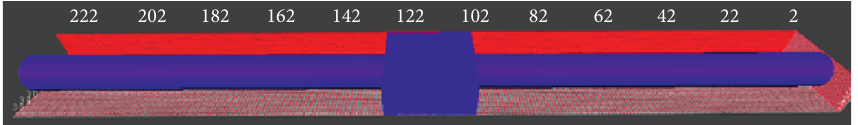
Figure 2: Numerical simulation grid diagram.